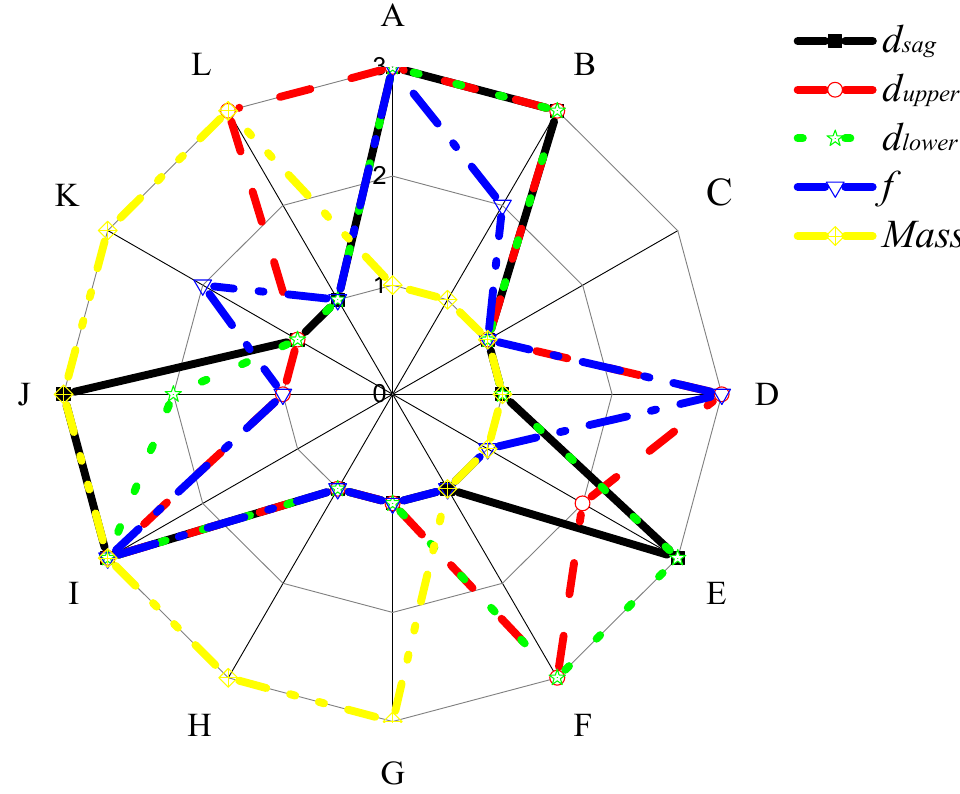
Figure 5. Single-objective optimisation for each response.